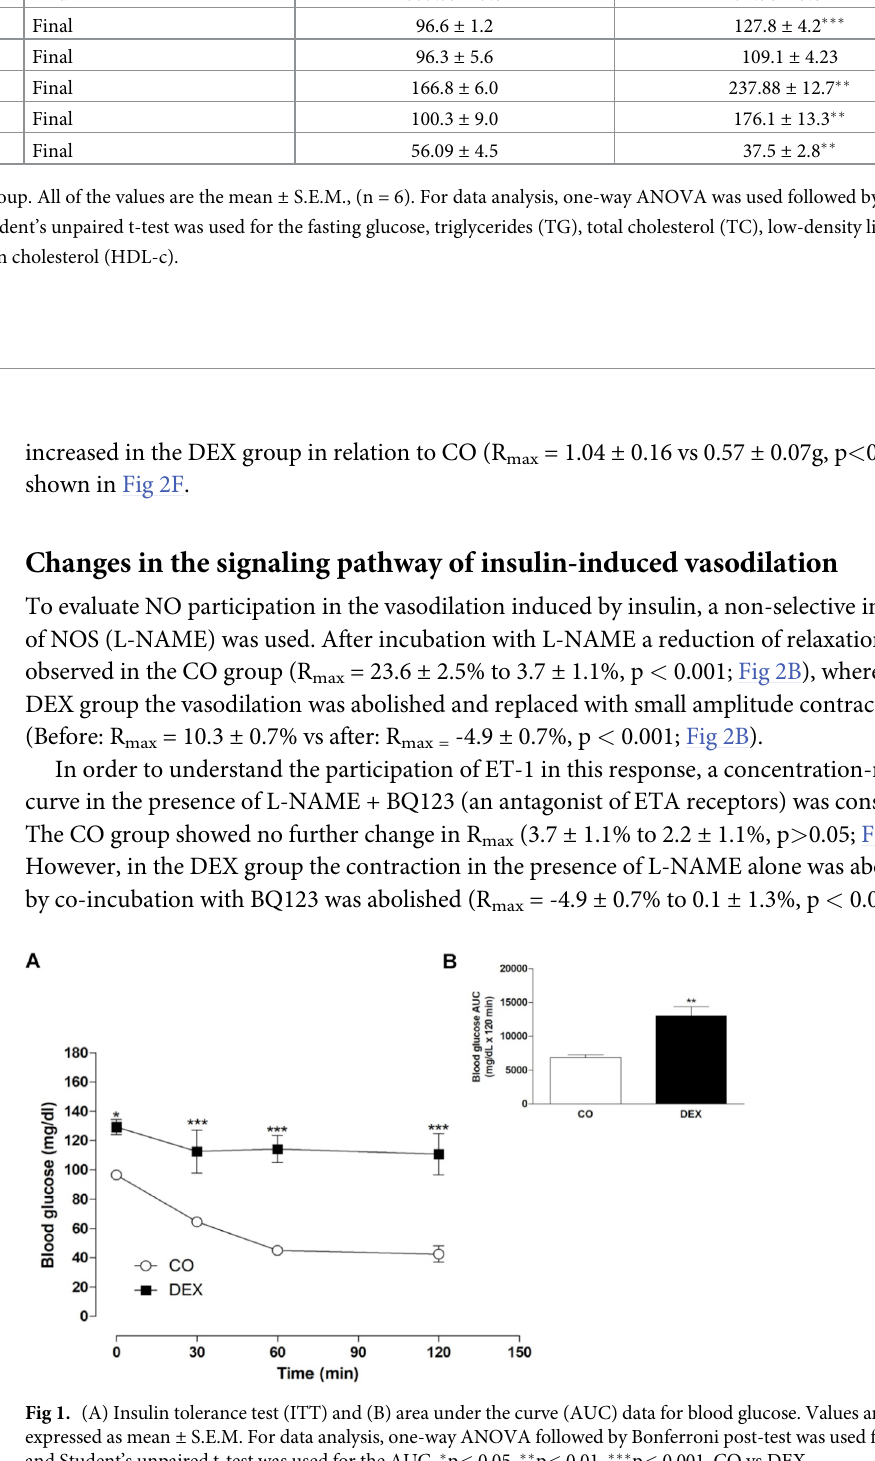
Table 2. Bodyweight in the first and eighth week, fasting glucose, TG, TC, LDL and HDL. Group